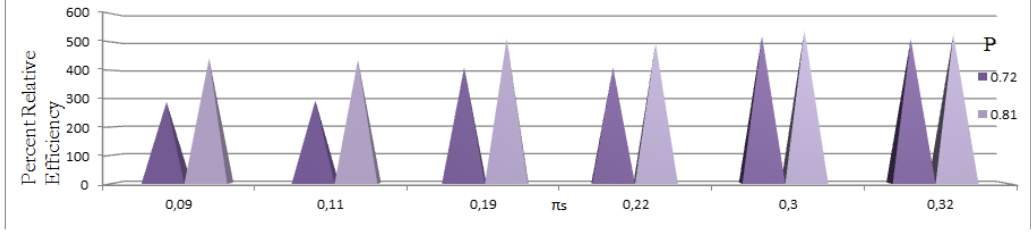
ˆ π (under proportional allocation) with respec ST ˆ π . mS